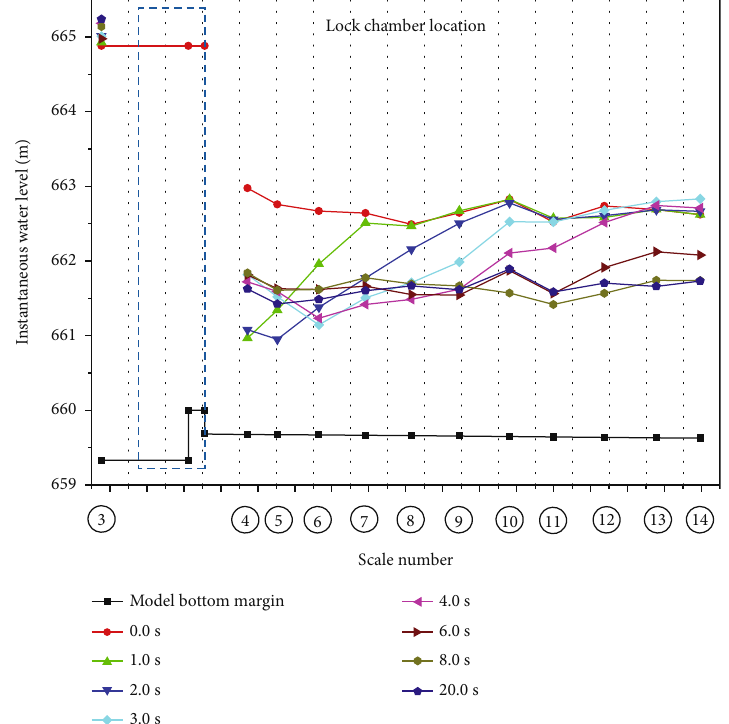
Figure 7: Instantaneous water surface pro fi le at di ff erent times under operating condition